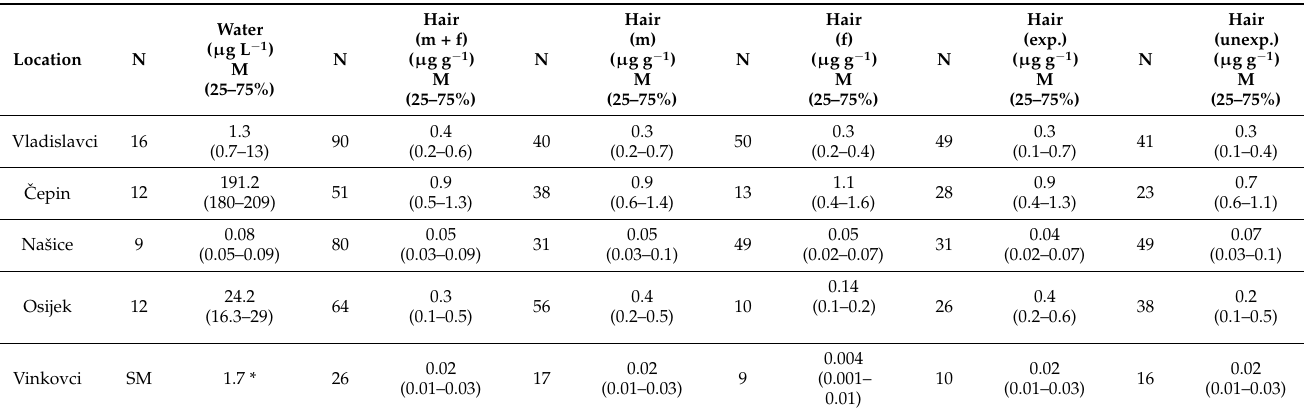
Table 1. Arsenic values in drinking water ( µ g L − 1 ) and hair ( µ g g − 1 ). Respondents who used only water are marked with unexposed, while those who were potentially occupationally exposed to external influences (fossil fuels, industry, fertilizers, etc.) are marked with exposed.